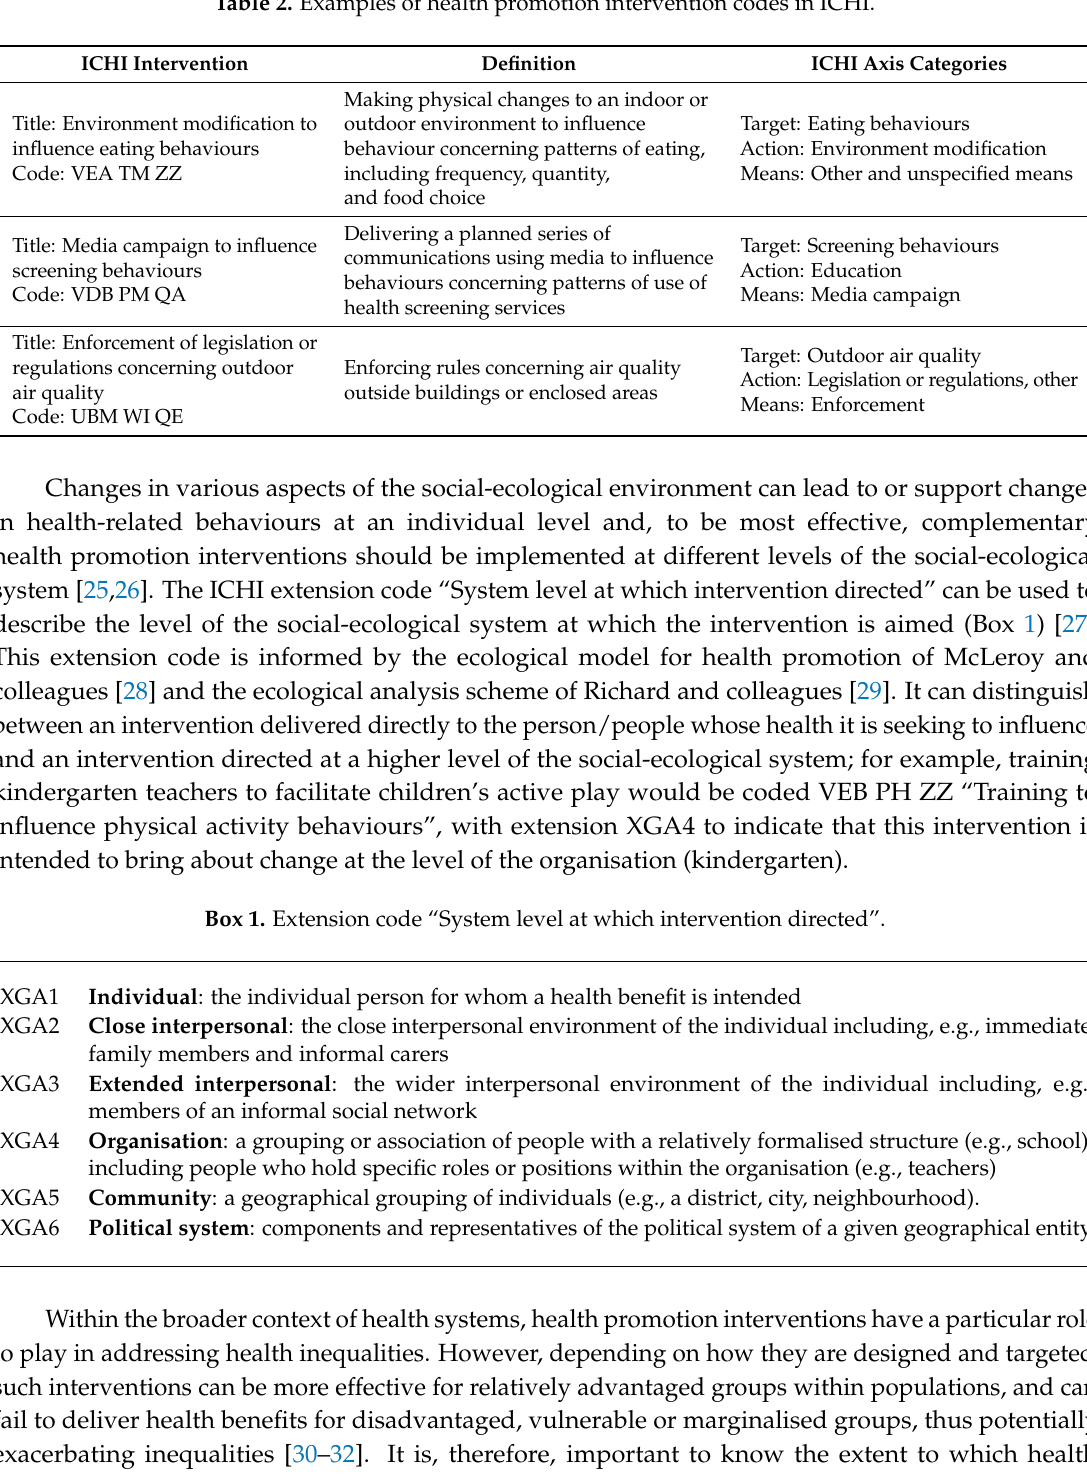
Table 2. Examples of health promotion intervention codes in